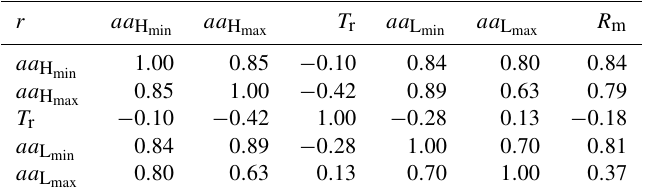
Table 2. Correlation coefficients between the parameters in Table 1.